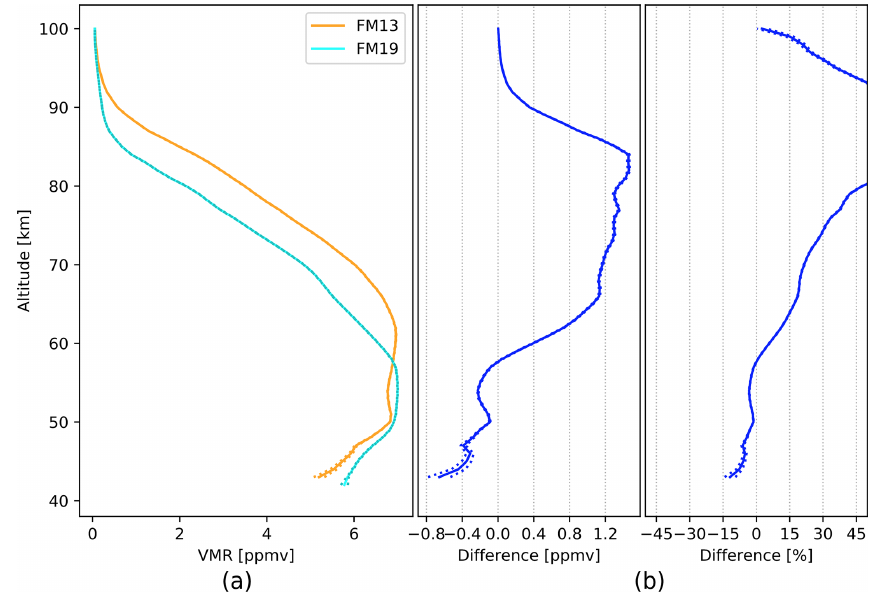
Figure A3. Absolute differences (a) and relative differences (b) between SMR v3.0 FM13 and FM19 H 2 O concentrations. The data plotted are global averages over the whole time period between February 2001 and April 2019.